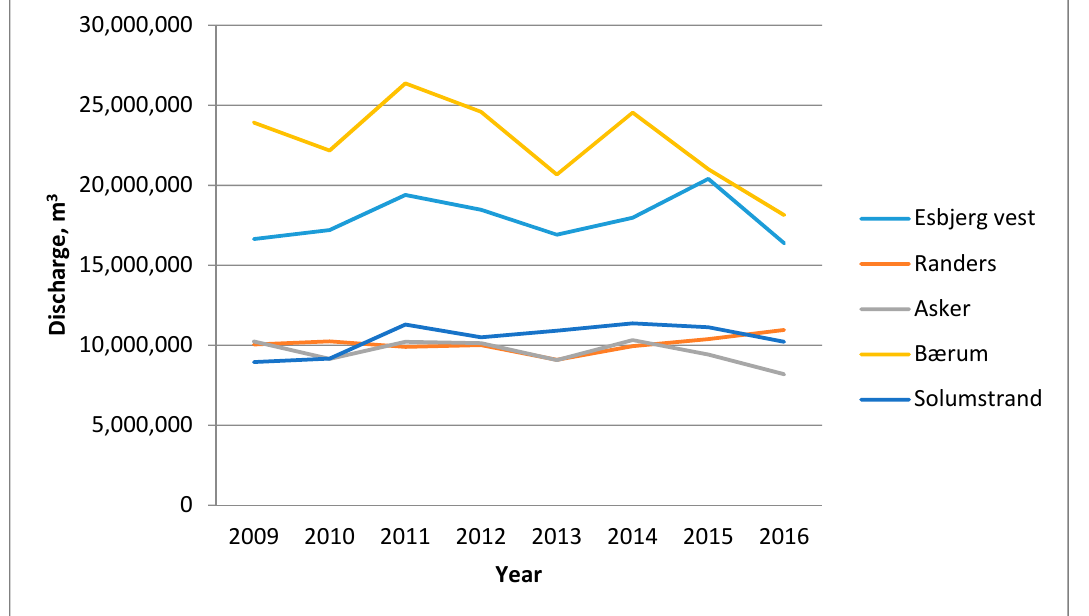
Figure 8. Discharge in Asker, Bærum, Drammen, Randers, and Esbjerg vest.